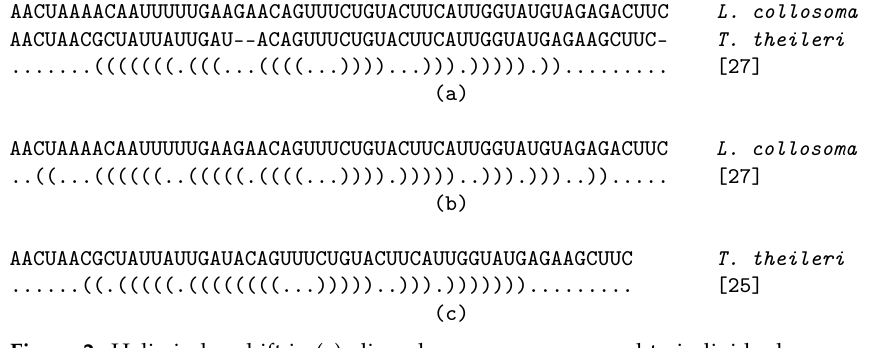
Figure 2. Helix index shift in ( a ) aligned sequences compared to individual sequences of the SL RNAs from ( b ) L. collosoma and ( c ) T. theileri